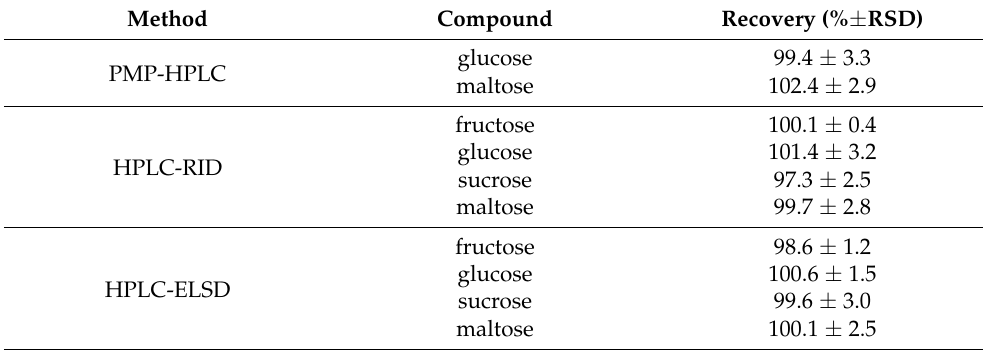
Numbers in bold represent the selected quantitative peak. d, double peak; t, triple peak.